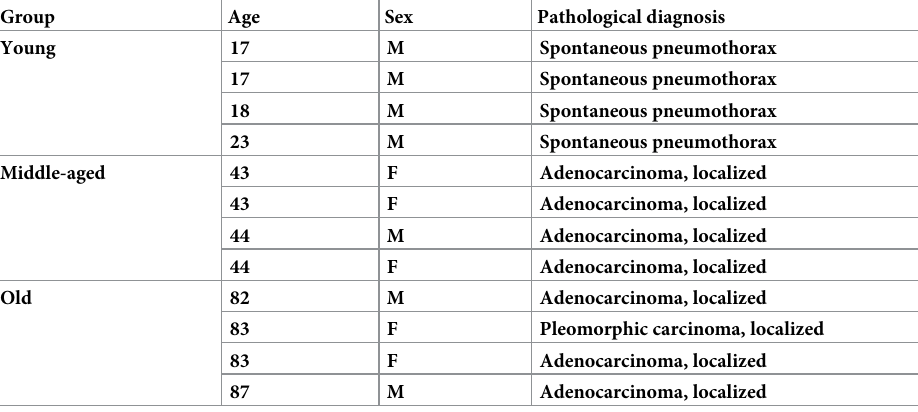
Table 1. List of human lung tissues used in the present study � . Group Age Sex